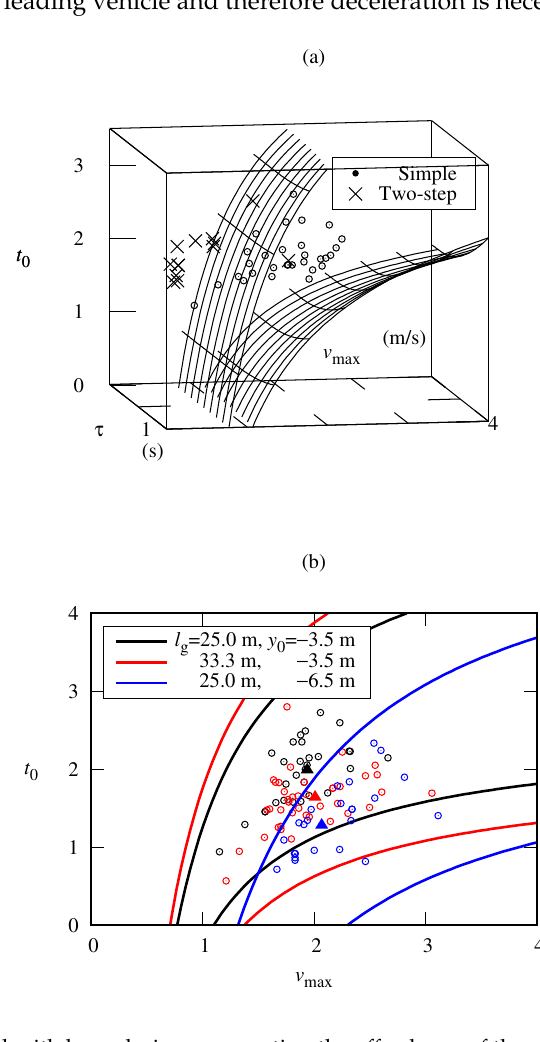
Figure 6. Data plotted with boundaries representing the affordance of the gap. ( a ) data plotted with surfaces in the three-dimensional parameter space ( τ , v max , t a ) defined by Equation (3). Data points for l g = 25m and y 0 = − 3.5m are plotted for all age groups; dots represent simple crossings and crosses represent two-step crossings; ( b ) data plotted with boundaries on the two-dimensional plane ( v max , t a ) defined by Equation (4). To illustrate the effects of a shift in affordance, data and boundaries for l g = 25m and y 0 = − 3.5m (black) are plotted with those for l g changed to 33.3m and for y 0 changed to − 6.5m are shown in red and in blue, respectively. Triangles indicate average parameter